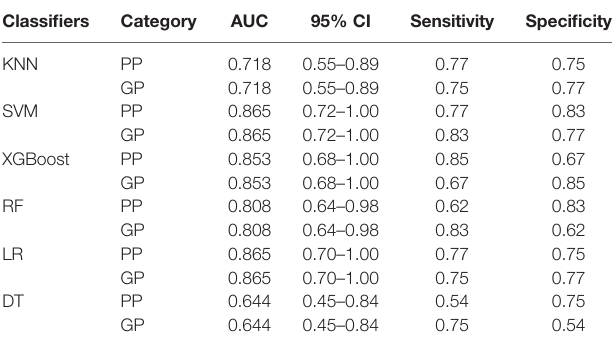
TABLE 6 | ROC results with six classi fi ers of validation set in portal venous phase.